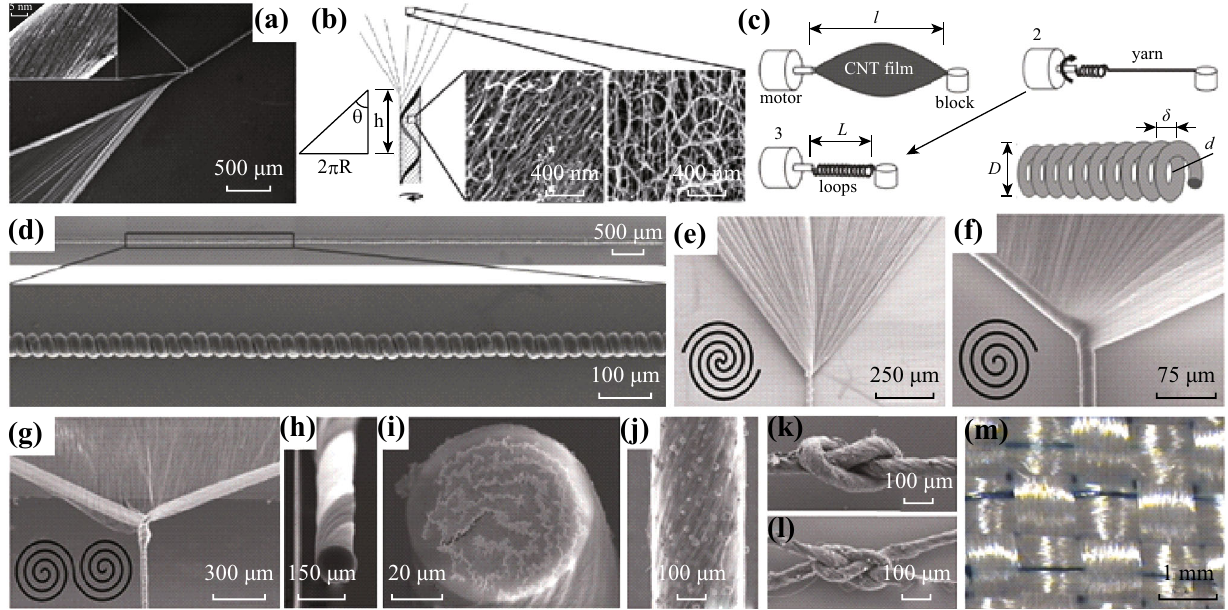
Fig. 7 a SEM image of a 200-nm-thick CF made from a CNT film with a width of 2 mm. b The schematic image left illustrates the twisting process induced elongation for the film and the two SEM images right come from the unstrained and strained part of the film, respectively. c Illustration of the spinning process of spring-like CNT ropes. d SEM images of a 4.4-mm-long section of rope consisting of highly uniform, perfectly arranged loops. SEM images of Fermat e , Archimedean f and dual Archimedean g type scrolls, which are illustrated in the insets, respectively. h , i SEM images of Si 3 N 4 NT@MWNT biscrolled yarn. The brighter areas correspond to MWNTs. j SEM image of TiO 2 @MWNT yarn. SEM images of overhand knot in 95% LiFePO 4 @MWNT yarn k and carrick bend knot between two 88% SiO 2 @MWNT yarns ( l ). m Photograph of 85% TiO 2 @MWNT yarn sewn into Kevlar textile. a , b Reproduced with permission from Ref. [33]. Copyright 2009, Wiley– VCH. c , d Reproduced with permission from Ref. [36]. Copyright 2012, Wiley–VCH. e – m Reproduced with permission from Ref.